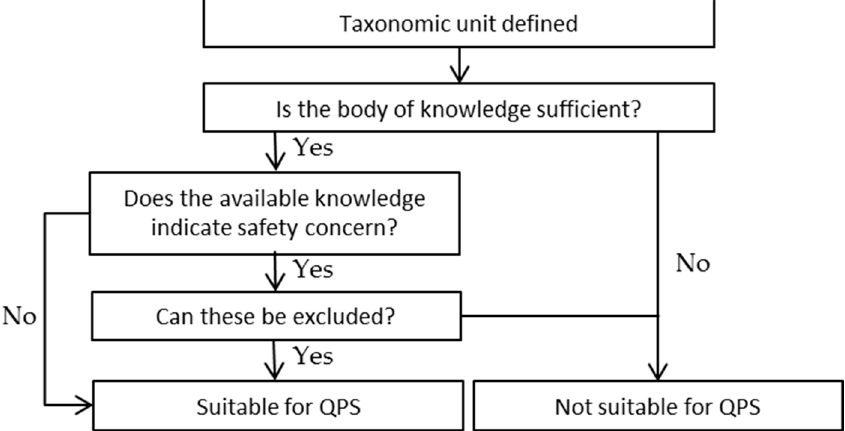
Figure 1. A generalised scheme for assessing the suitability for Qualified Presumption of Safety QPS status of a microorganism.